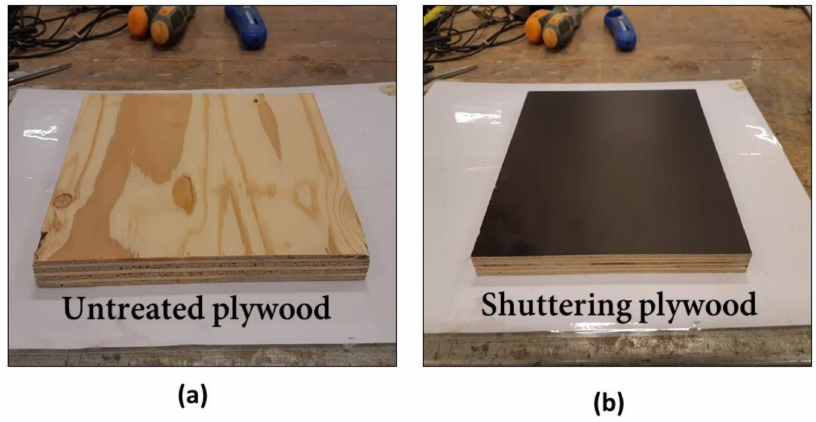
Figure 3. Types of used plywood formwork for composite column—untreated treated plywood (UTT) and shuttering plywood